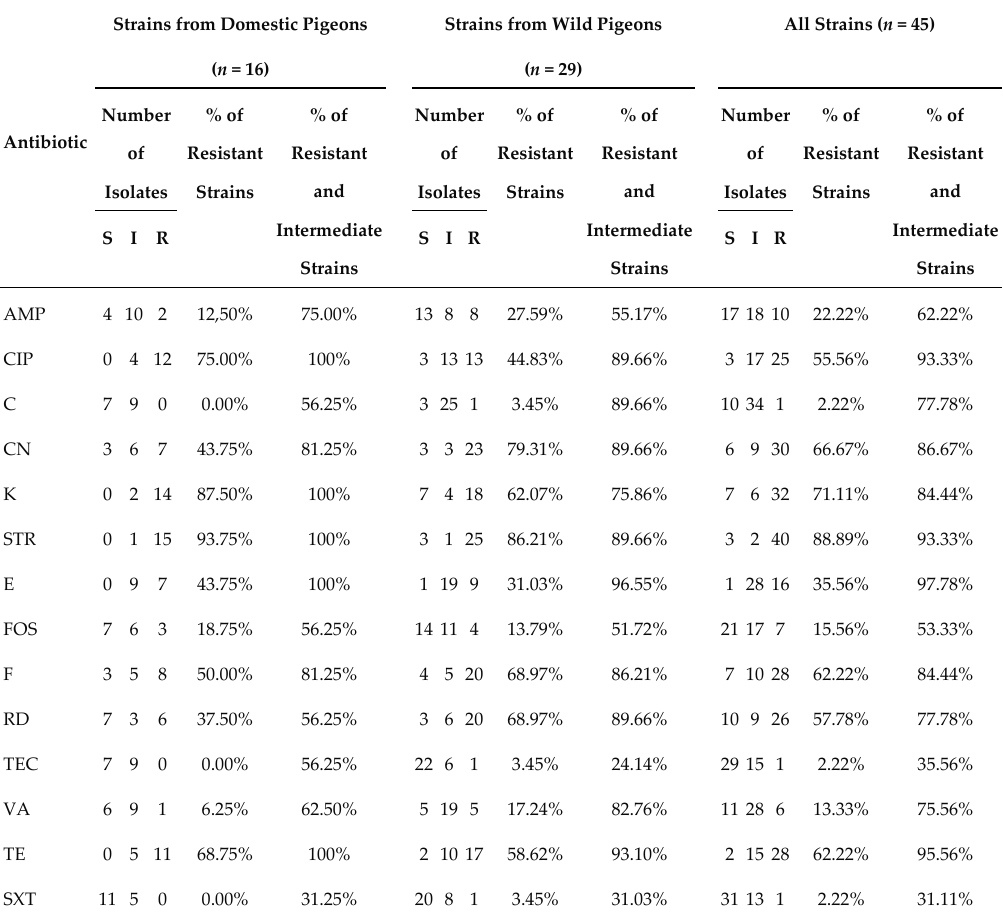
Table 4. Number and percentage of Enterococcus faecalis strains susceptible, intermediate or resistant to each antibiotic tested.